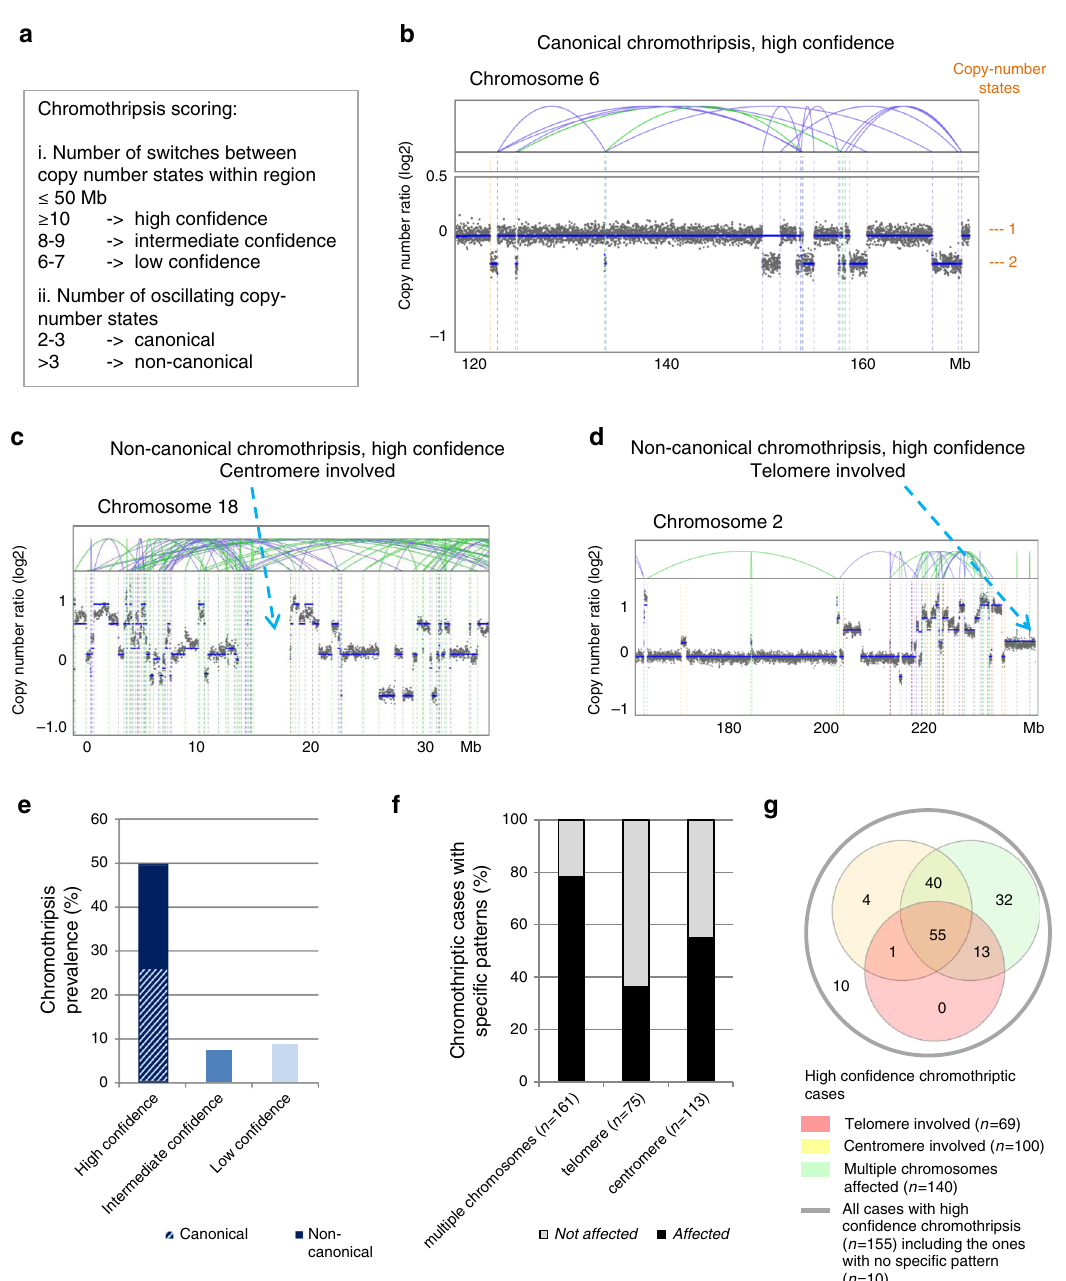
Fig. 1 Chromothriptic patterns and prevalence in 316 whole-genome sequences. a Chromothripsis scoring: criteria to determine the con fi dence of the scoring and to de fi ne canonical versus non-canonical chromothripsis. b Representative example of canonical chromothripsis. c Representative example of non-canonical chromothripsis. In this case, the centromere is included in the chromothriptic region. d Representative example of chromothriptic chromosome for which the telomere region is involved. e Chromothripsis prevalence shown as percentage of cases ( n = 316, whole-genome sequencing) including cases with high con fi dence, intermediate con fi dence and low con fi dence chromothripsis. For tumours with high con fi dence chromothripsis, we distinguish between canonical and non-canonical chromothriptic patterns. f Chromothripsis cases with multiple versus single chromosomes affected; with or without telomere involvement (illustrated in d ), as well as with or without centromere involvement (illustrated in c ) from all 316 cases. High con fi dence, intermediate con fi dence and low con fi dence chromothriptic cases are shown. g Venn diagram showing the overlapping fractions of high con fi dence chromothriptic cases with multiple chromosomes affected, with or without involvement of telomeres and/or centromeres. Analyses based on whole- exome sequences and examples showing the counting of switches between copy-number states are shown in Supplementary Figs. 1 – 2. On the copy- number plots, blue lines indicate inversions, green lines indicate break ends, brown lines indicate translocations and orange lines indicate copy-number